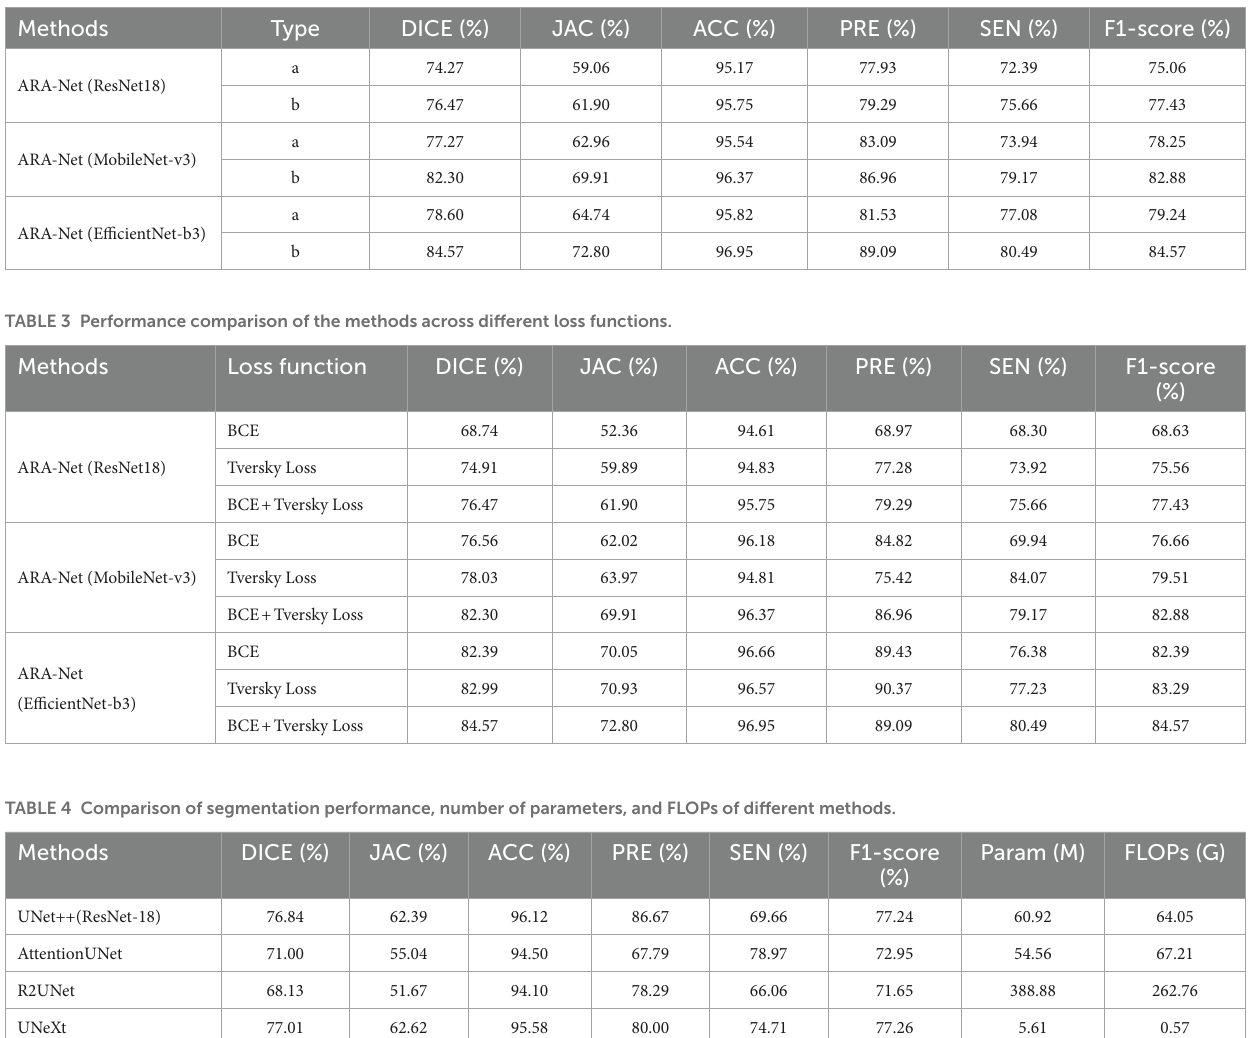
TABLE 2 Performance comparison of the proposed method with and without using transfer learning.